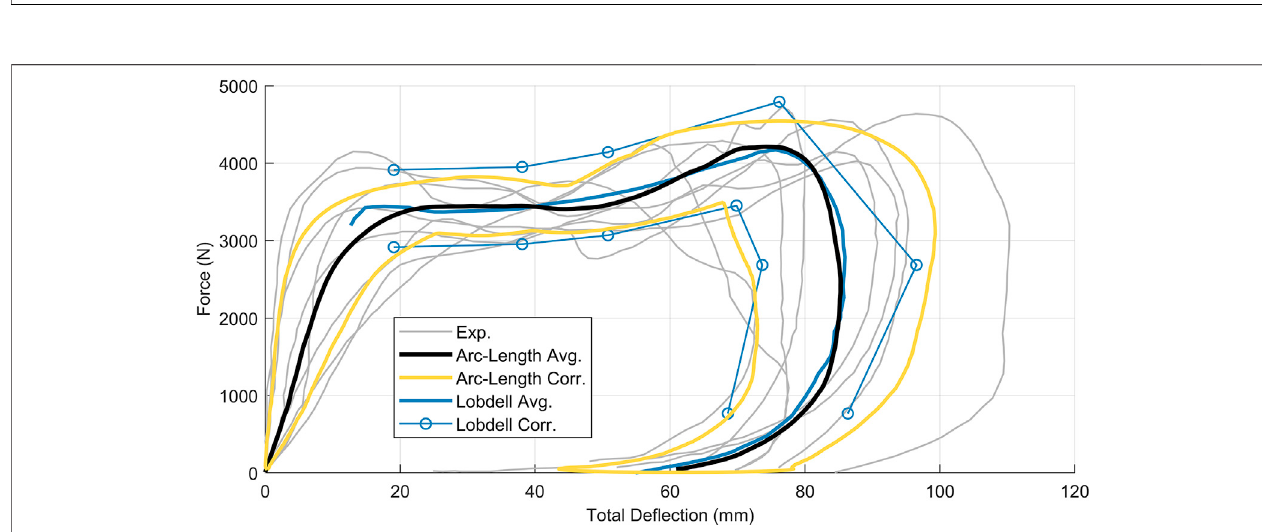
FIGURE 12 | Kroell force-displacement signals overlaid with arc-length average (black) and corridors (gold) as well as the Lobdell corridors (blue). Arc-length corridors are ± 1 standard deviation, m = 2 control points, λ (cid:2) 10 − 2 .